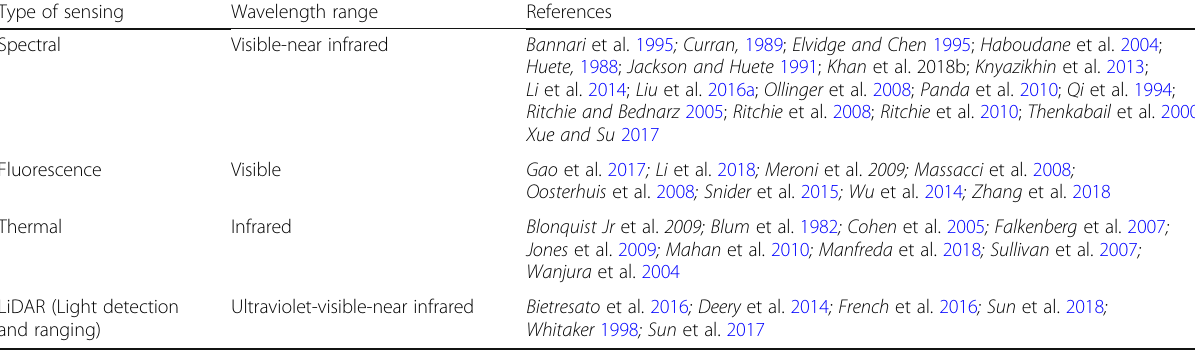
Table 1 Summary of the sensing techniques typically used in high-throughput phenotyping applications in cotton Type of